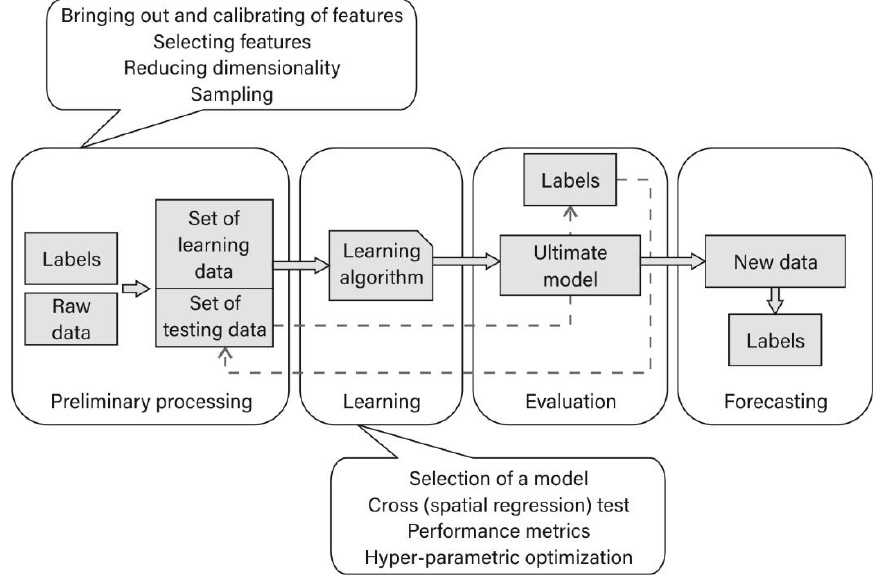
Figure 8. Predictive modelling, adapted from [22].